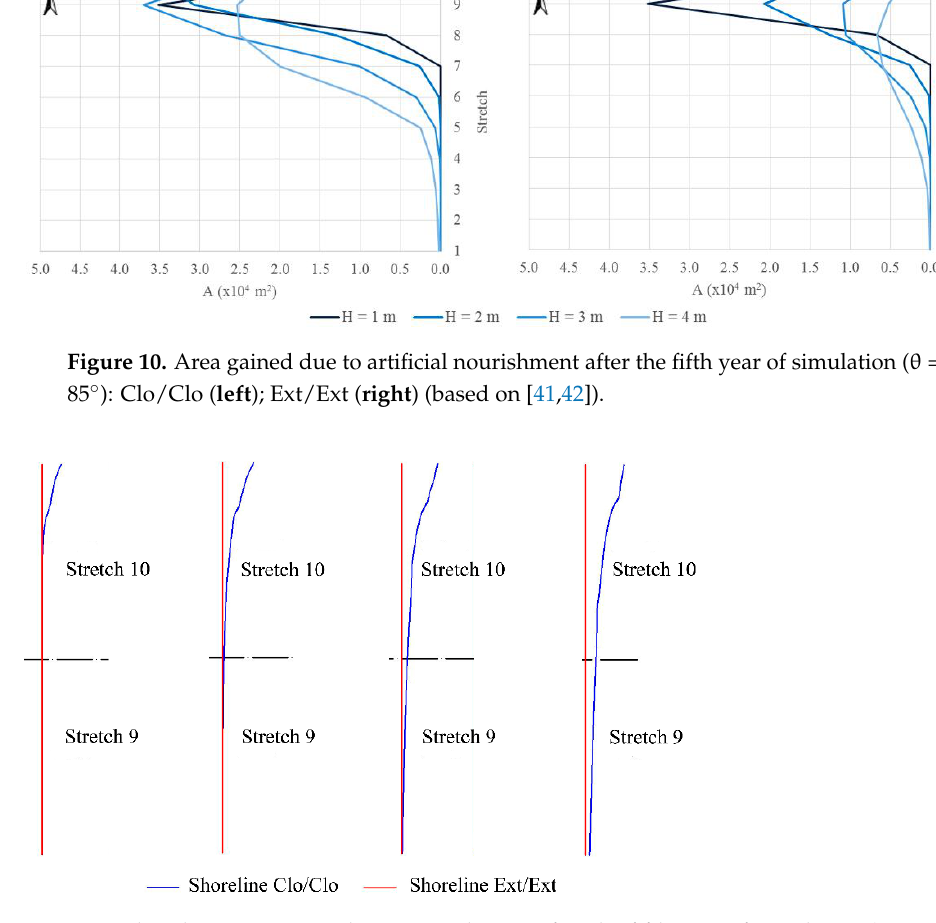
Figure 10. Area gained due to artificial nourishment after the fif th year of simulation (θ = 85°): Clo/Clo ( left ); Ext/Ext ( right ) (based on [41,42]).